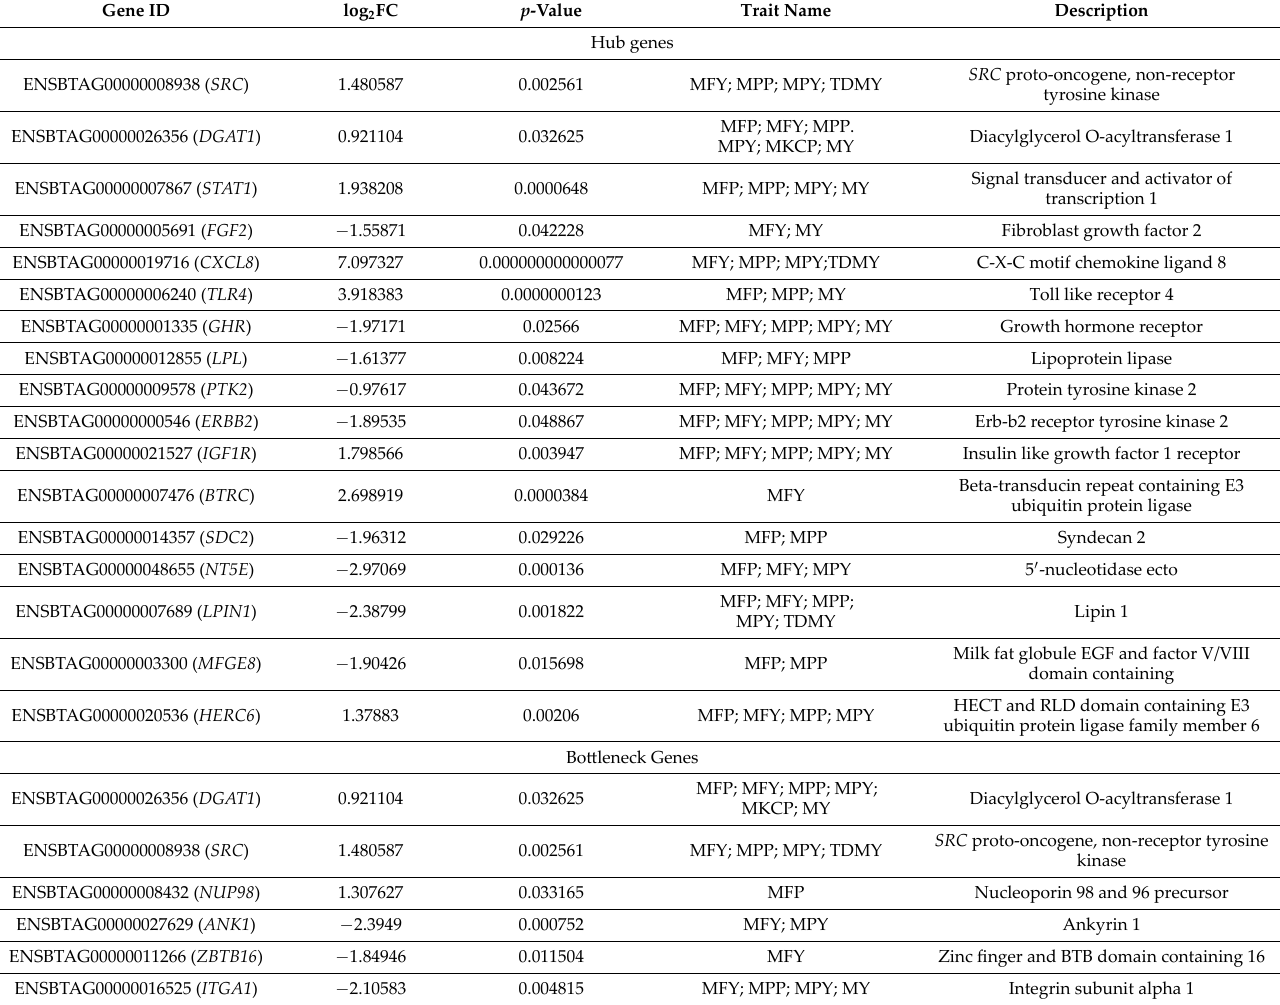
Table 1. Differentially expressed hub and bottleneck QTL genes of the protein interaction network of fat QTL